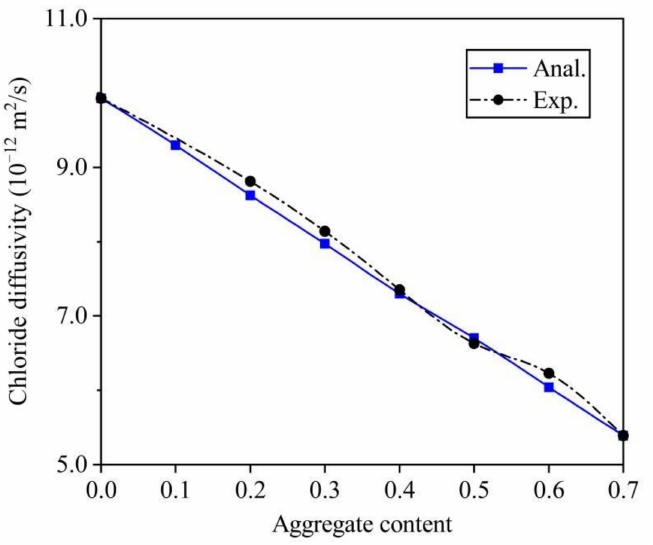
Figure 5. Comparison with self-conducted test